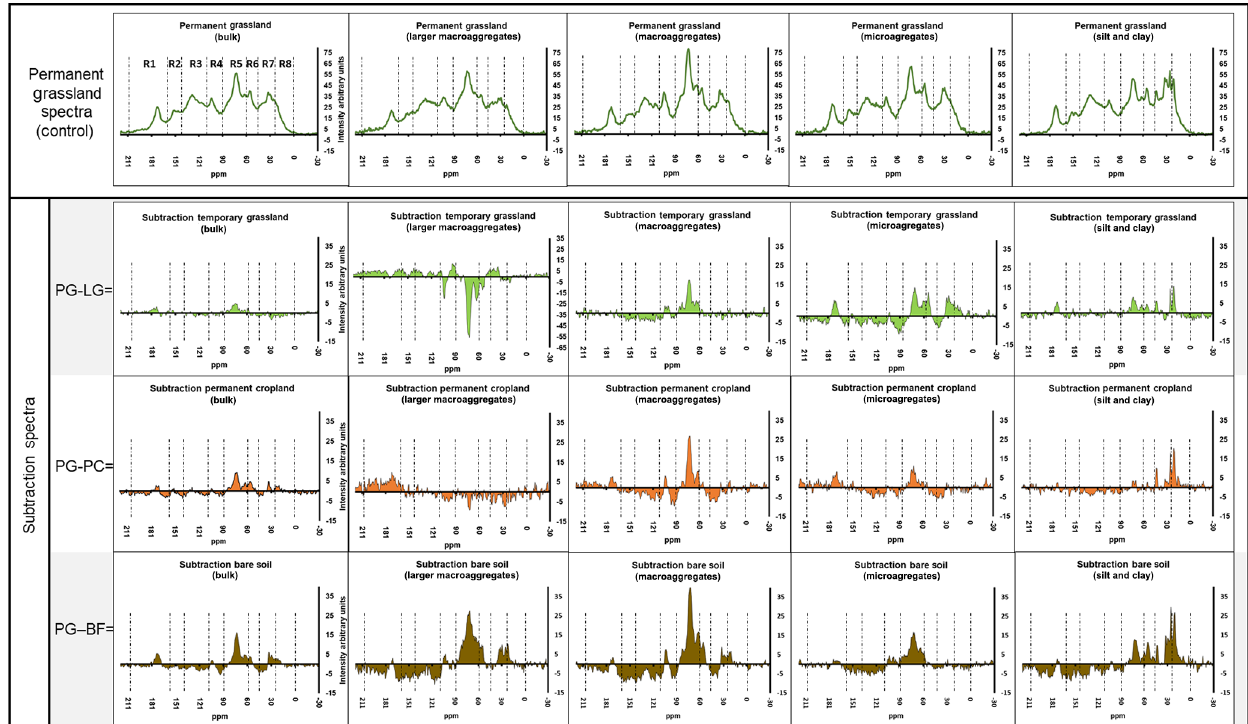
Figure 7. Comparisons of 13 C NMR spectra based on subtractions of the spectra obtained from ley grassland (LG), permanent cropland (PC), and bare fallow (BF) samples from the homologous spectra obtained from permanent grassland (PG; first row, used as control). Spectral regions include carboxyl C (R1), heteroaromatic (R2), aromatic (R3), anomeric (R4), O -alkyl (R5), N -alkyl (R6), alkyl (R7), and terminal alkyl (R8). All the intensities of all the resulting spectra were normalized by an arbitrary factor (10000) to fit within the interval of − 2 to + 40 arbitrary units on the graphs. The y axes of all the graphs were scaled to the same interval of the arbitrary units, except for LMAs of ley